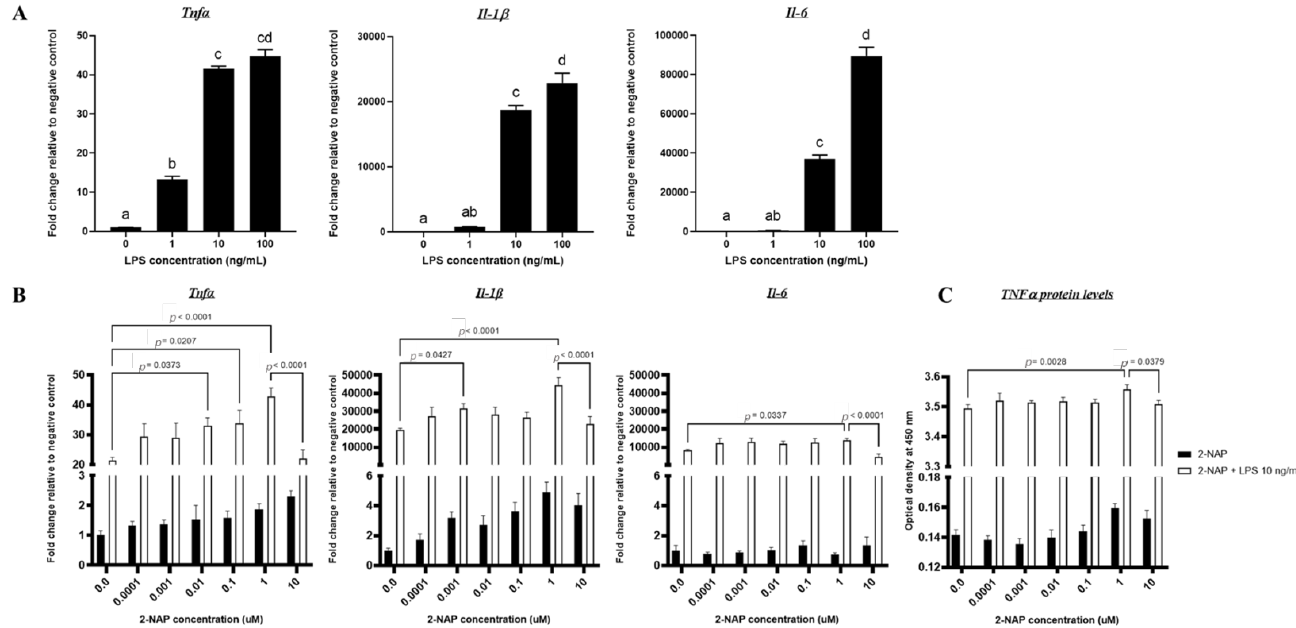
Figure 1. Acute 2-NAP treatment of RAW264.7 macrophages upregulates proinflammatory cytokine expression. ( A ) The effect of LPS on proinflammatory gene expression in RAW264.7 macrophages. Cells were stimulated with LPS for 4 h. Following stimulation, mRNA was extracted and assayed for relative gene expression of Tnf α , Il-1 β , and Il-6 by RT-PCR. The values shown represent the mean ± SEM of replicate samples from one experiment ( n = 4). Groups labeled with different letters (a, b, c, and d) are statistically different from each other. ( B ) Macrophages were either treated with 2-NAP alone–six 10-fold concentrations (10 pM–10 µ M concentrations) or stimulated with LPS conditions. Solvent control—DMEM + 0.01% ethanol (EtOH); LPS control—DMEM + LPS 10